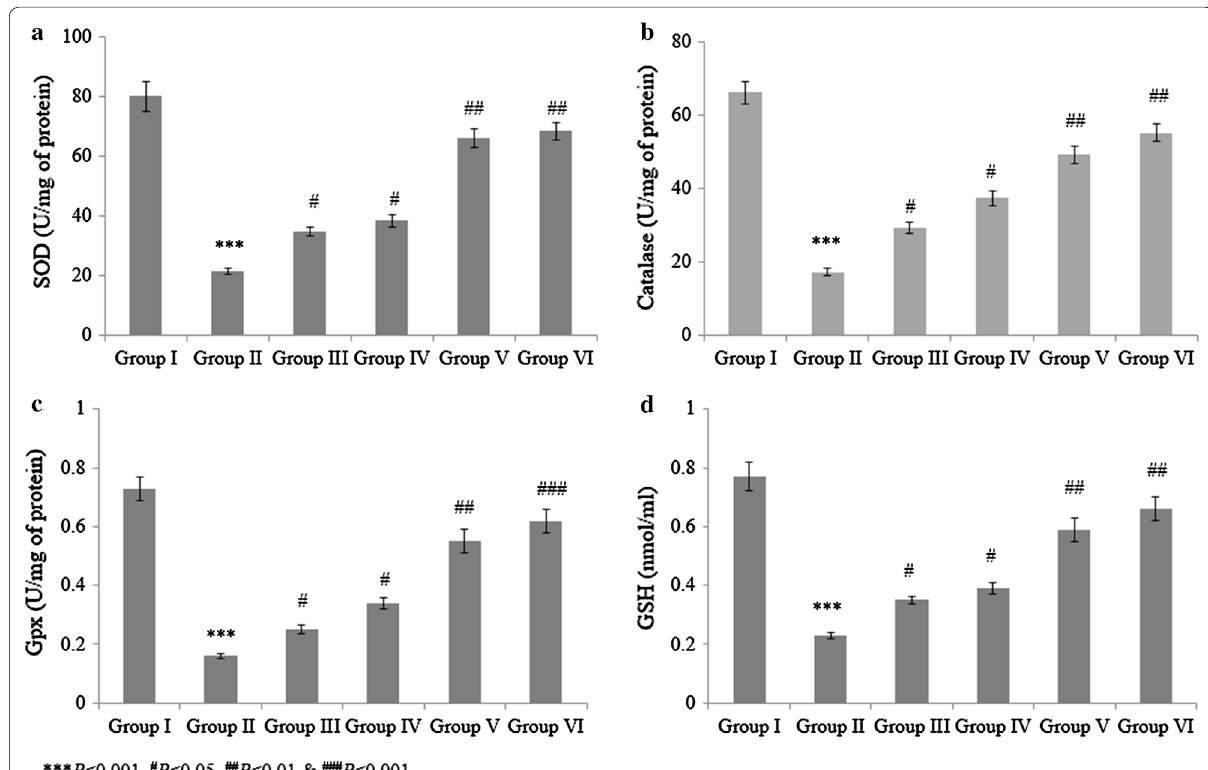
Fig. 4 Effects of erythropoietin and sesame oil on the levels of antioxidants a superoxide dismutase (SOD), b catalase, c glutathione peroxidase (Gpx), and d reduced glutathione (GSH) in rats with ischemic kidney injury after kidney transplantation. *** P < 0.001 vs. sham rats; # P < 0.05, ## P < 0.01, and ### P < 0.001 vs. control